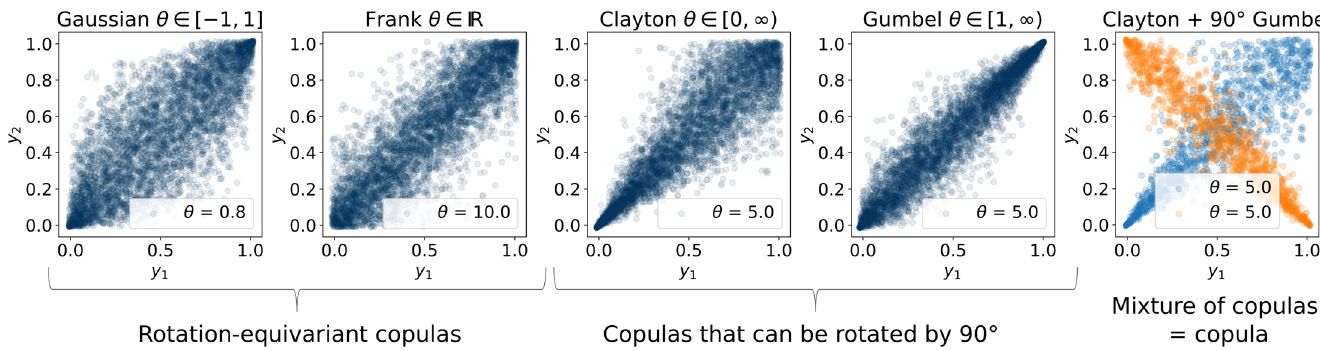
Fig 1. Copula families used in the mixture models in our framework. Each panel shows a scatter plot of samples drawn from a parametric copula family (named in the title of each plot) with a fixed parameter θ (shown in the bottom right corner). In total, we used 10 different copula elements—Gaussian + Frank + 4 × Clayton + 4 × Gumbel—to construct copula mixtures. The rightmost figure shows a mixture of two copulas from different copula families taken with equal mixing weights (0.5). Blue points here correspond to the samples drawn from a Clayton copula, orange points—to a 90˚-rotated Gumbel copula. Note, that a mixture of copulas is a copula